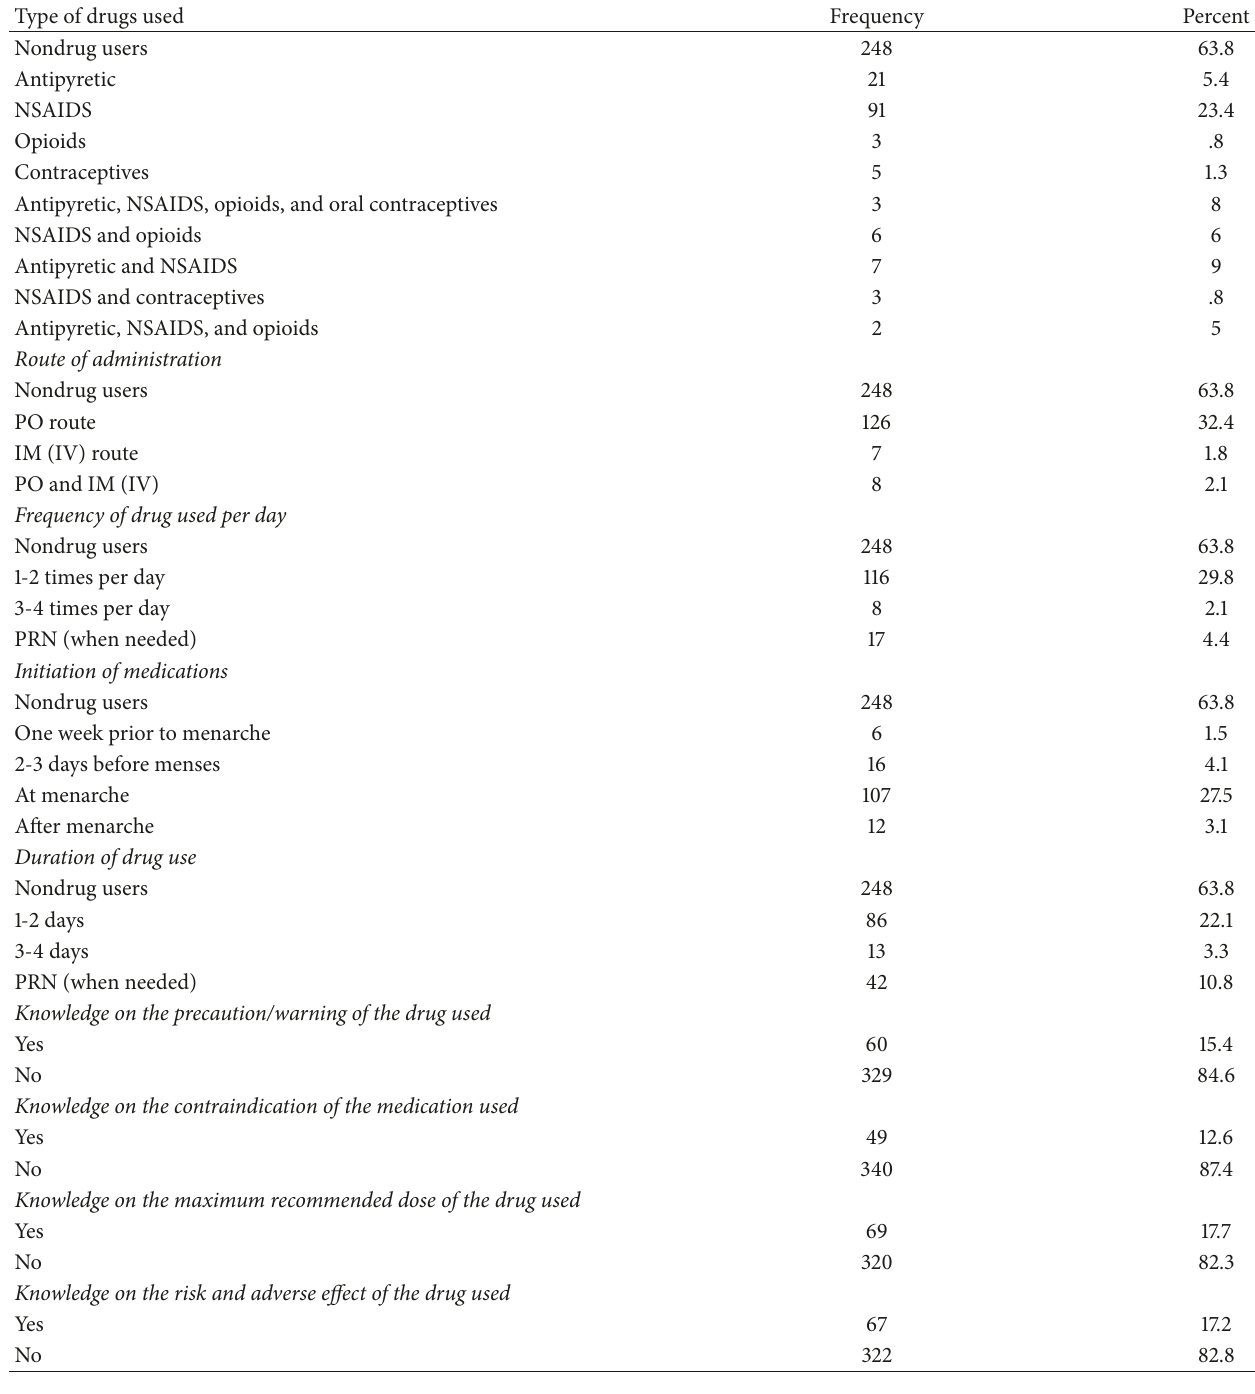
Table 2: Types of medications used, knowledge about drugs, and medication practice of the respondents, Gondar, 2016. Type of drugs